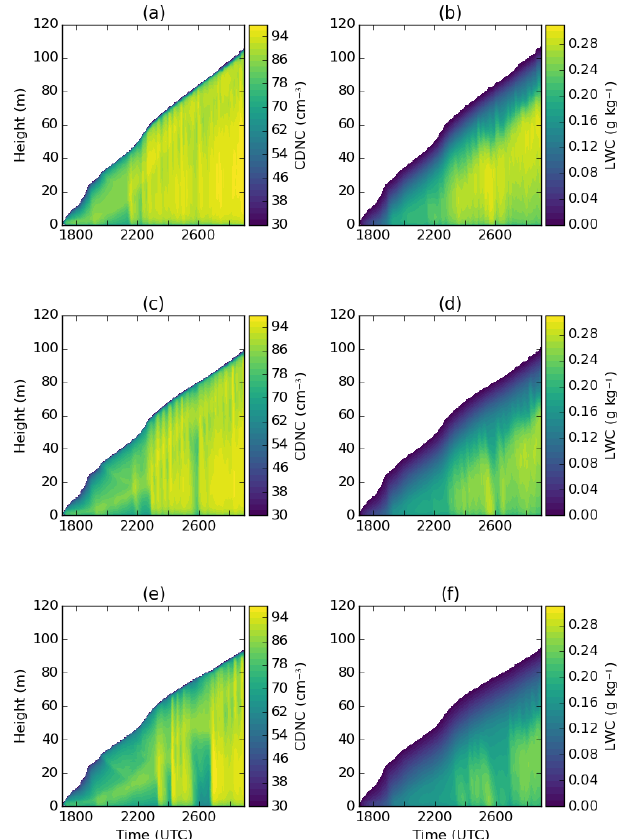
Figure 7. Plots of panels (a) , (c) and (e) show the average FDNC (cm − 3 ); and panels (b) , (d) and (f) show the average LWC (gkg − 1 ). Panels (a) and (b) show T_SMOD; panels (c) and (d) show T_SMOD_er_15; panels (e) and (f) show T_SMOD_er_20. T_SMOD and T_SMOD_er_20, with T_SMOD_er_20